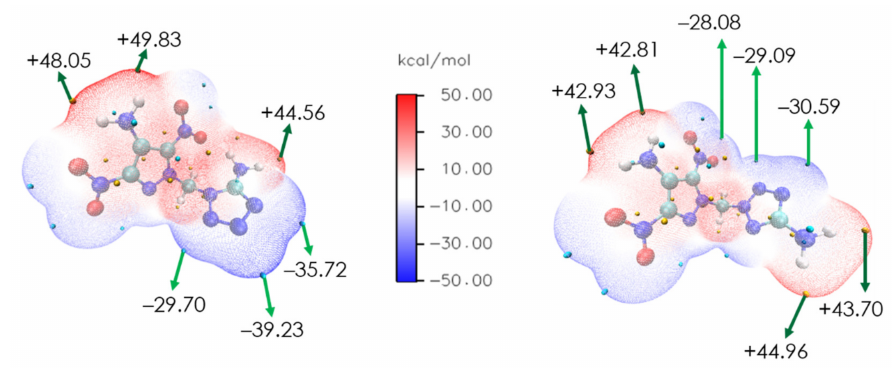
Figure 3. The electrostatic potential surfaces for DMPT-1 and DMPT-2 .